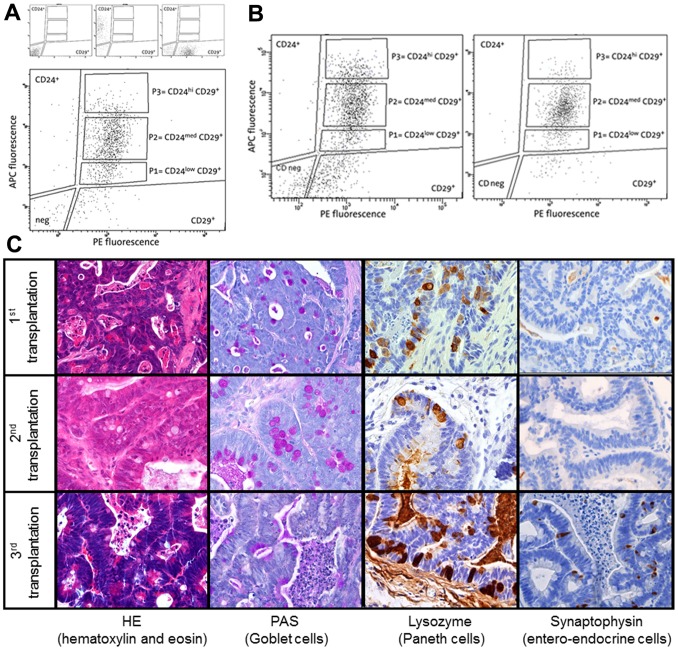
FACS analysis of cell suspensions from Apc
1638N/+/KRAS
V12G tumours.
a. Large panel: dot plot representative of the staining pattern obtained by staining with anti-CD24 APC-conjugated and anti-CD29 PE-conjugated antibodies. Lineage positive cells (Lin+) were excluded (gated out) by staining with biotinylated antibodies against lineage markers and Streptavidin-PerCPCy5.5. P1 (Lin−CD24lowCD29+), P2 (Lin−CD24medCD29+), and P3 (Lin−CD24hiCD29+) populations are indicated in the plot. Small panels: dot plots representative of cells stained with isotypic control antibodies (left), compensation control stained only with anti CD24-APC antibodies (middle), compensation control stained only with anti CD29-PE antibodies (right). b. FACS analysis of the CD24/CD29 pattern of tumours obtained by serial transplantation of P3 cells suspensions from Apc
1638N/+/KRAS
V12G intestinal tumours. Left: primary transplantation. Right: secondary transplantation. c. Immunohistochemistry analysis of tumors obtained by 3 rounds of serial transplantation of P3 cells suspensions from Apc
1638N/+/KRAS
V12G intestinal tumours.